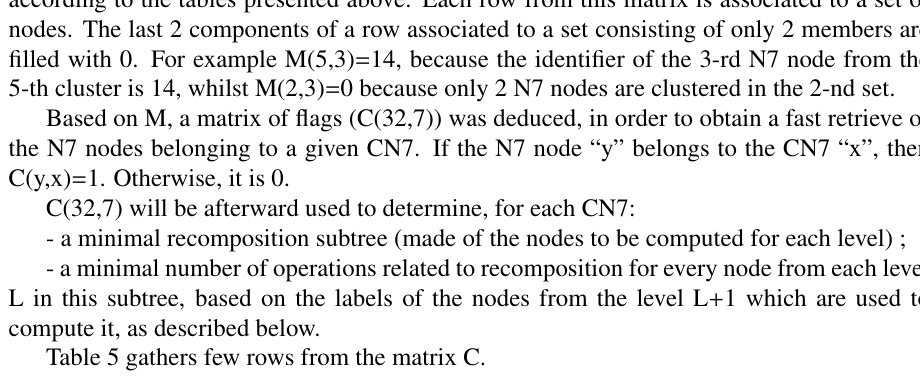
Figure 2. Maximum values of the ratio be- tween the energy of the 5-th node and the sum between the energies of the 5-th and 13- th nodes when the 15-th and 17-th harmonics act jointly in a T7